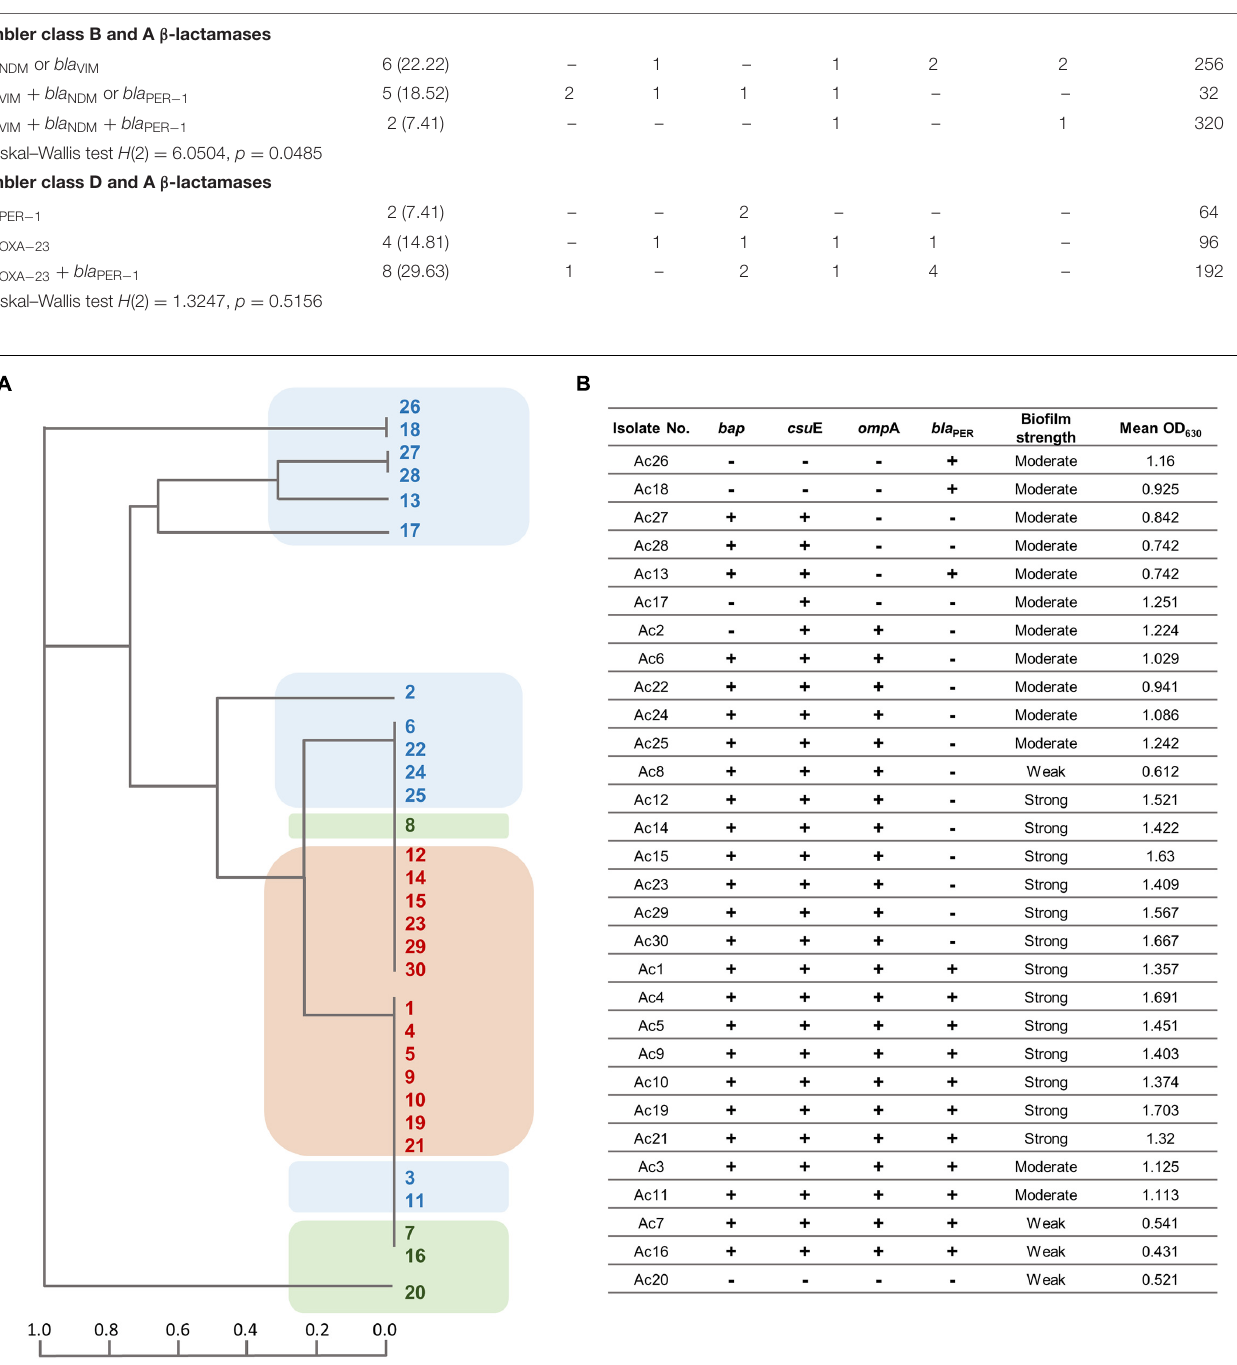
FIGURE 3 | (A) Dendrogram signifying the clustering relatedness of 30 MDR A. baumannii isolates based on their PCR results for biofilm-related genes. The clusters are highlighted according to their biofilm strength (brown, strong; blue, moderate; green, weak biofilm forming). (B) Tabular presentation of the PCR screening results of biofilm associated genes and corresponding mean OD 630